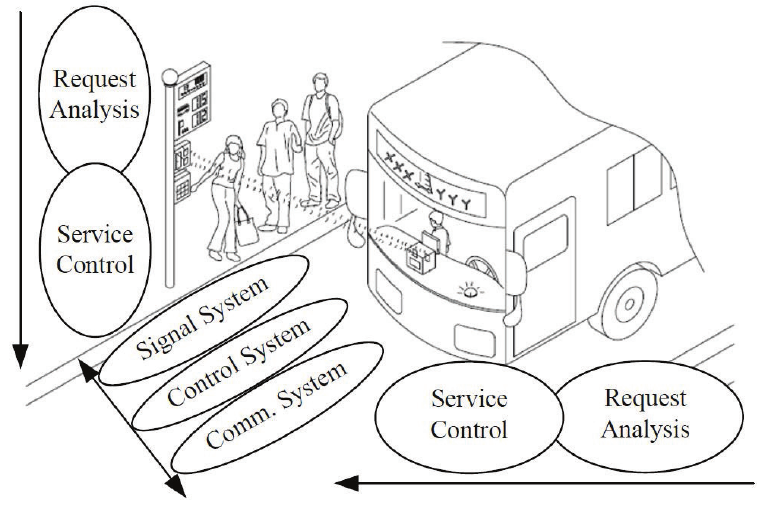
Figure 1. Intelligent bus system model: the direction of information flow is represented by